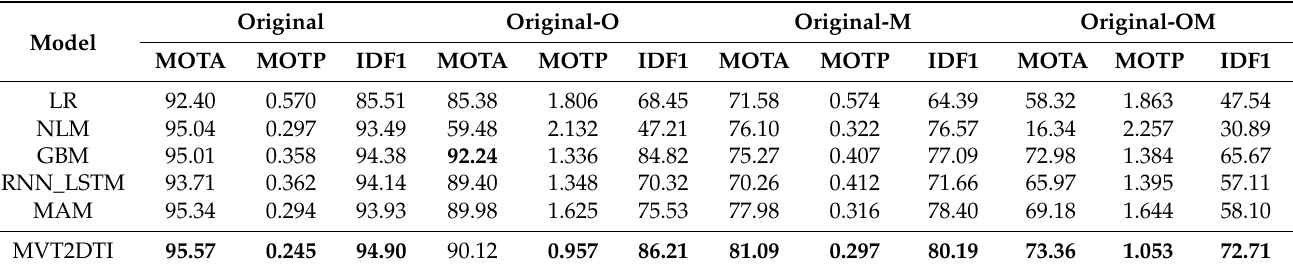
Table 2. The performances of all the baseline models and MVT2DTI under the three metrics on four scene datasets.